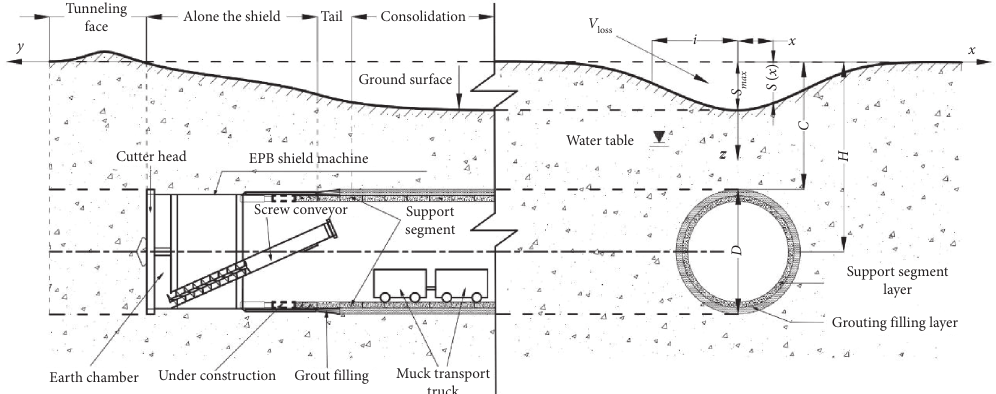
Figure 2: Ground loss due to EPB shield